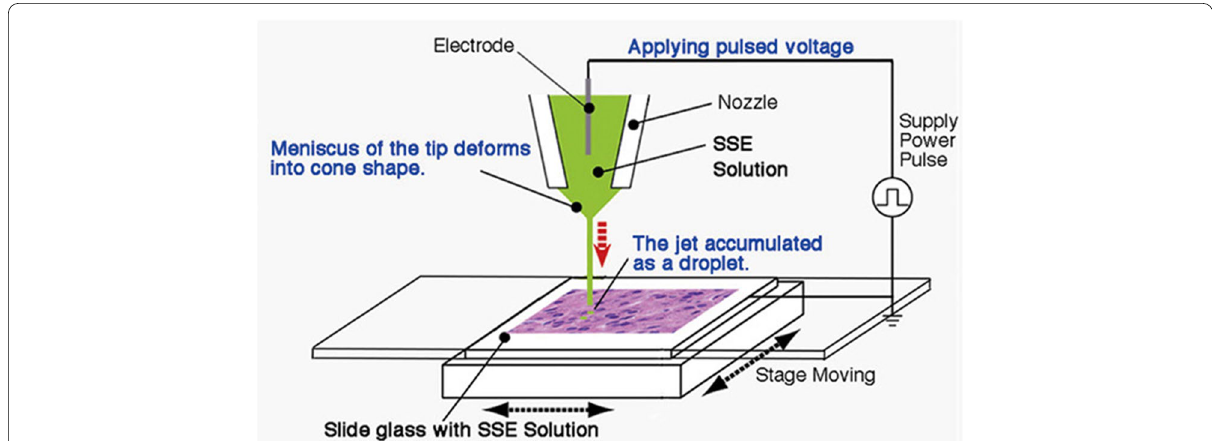
Fig. 10 Droplet spotter system. Minute droplets of undiluted surface shield enhancer (SSE) solution are applied at multiple locations with the computer-controlled system. From Kawasaki et al. 2020 with permission from the